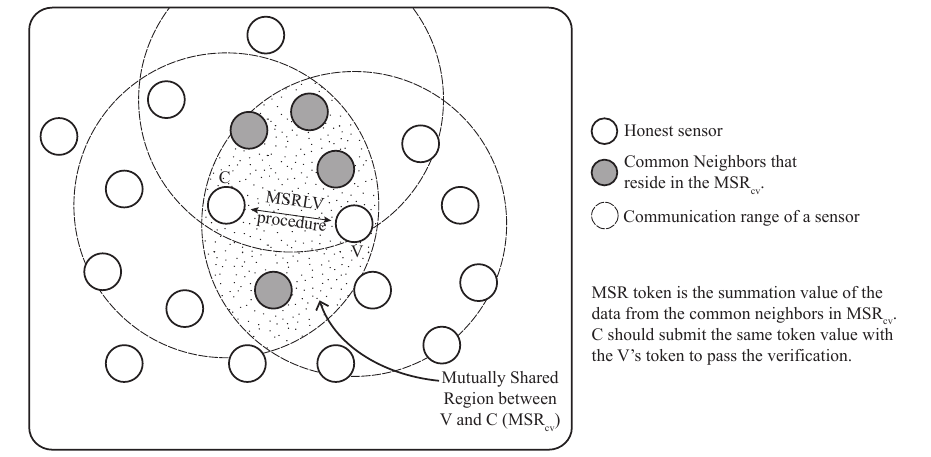
Figure 2. An example of mutually-shared region (MSR) token